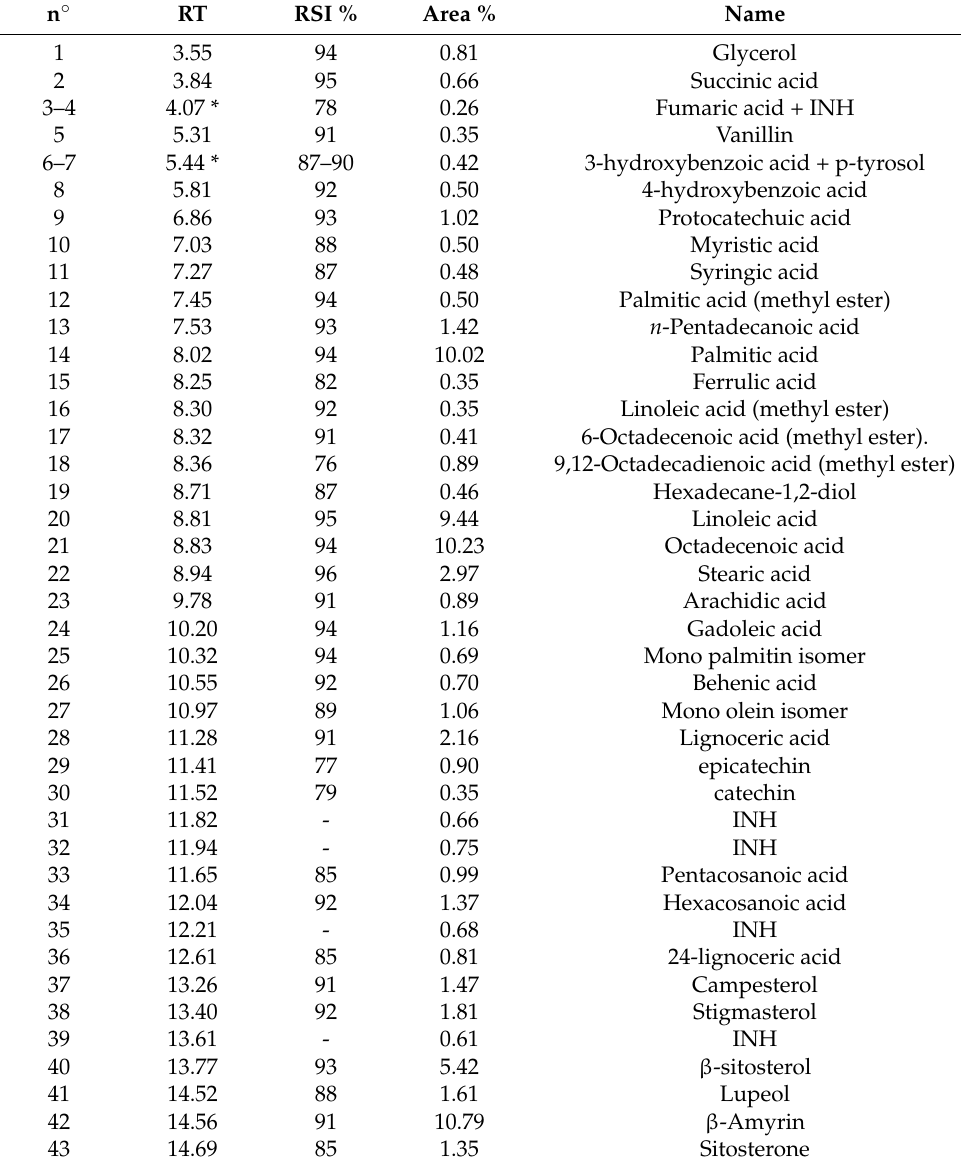
Table 7. GC-MS results of dichloromethane fraction of D. oliveri trunk bark after